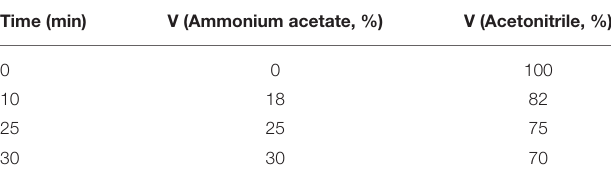
TABLE 4 | Primer sequences of RT-qPCR